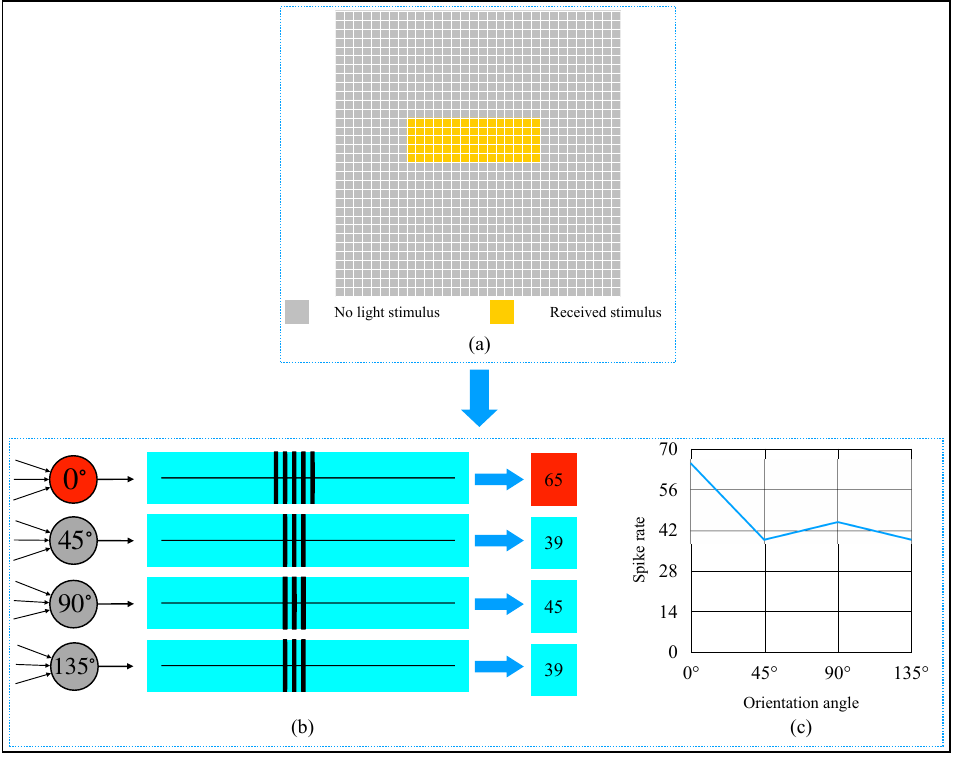
Figure 12. Computer simulation results of orientation detection on an object with 0 ◦ orientation angle. ( a ) Object. ( b ) Spike records. ( c ) Spike rate curve of four types of complex cells.